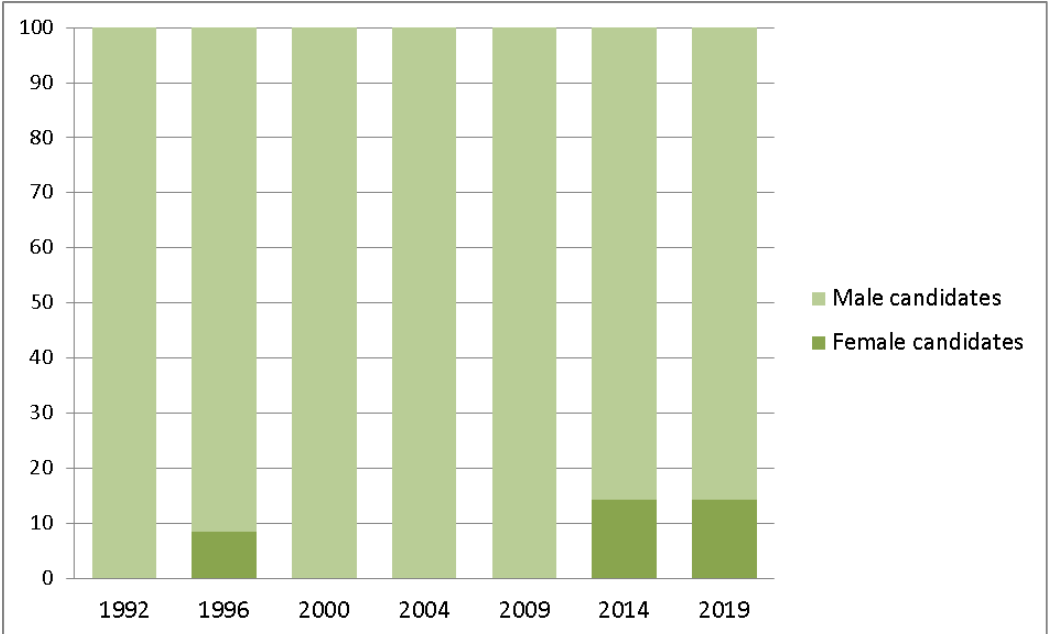
Figure 2: The proportion of the Presidential candidates, by gender, 1992 – 2019 Source: